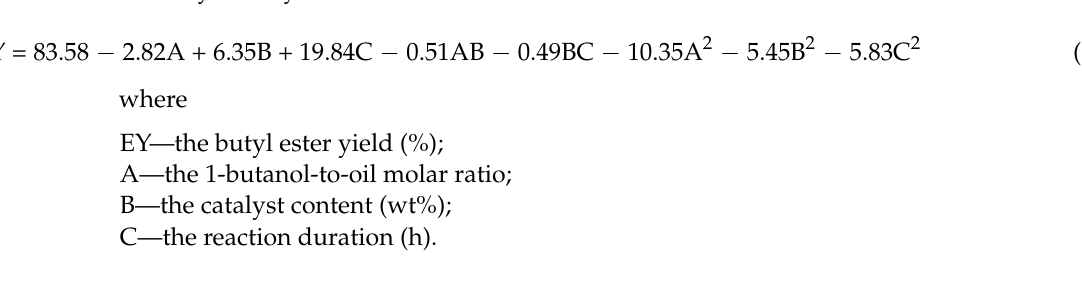
Table 2. Analysis of variation of quadratic